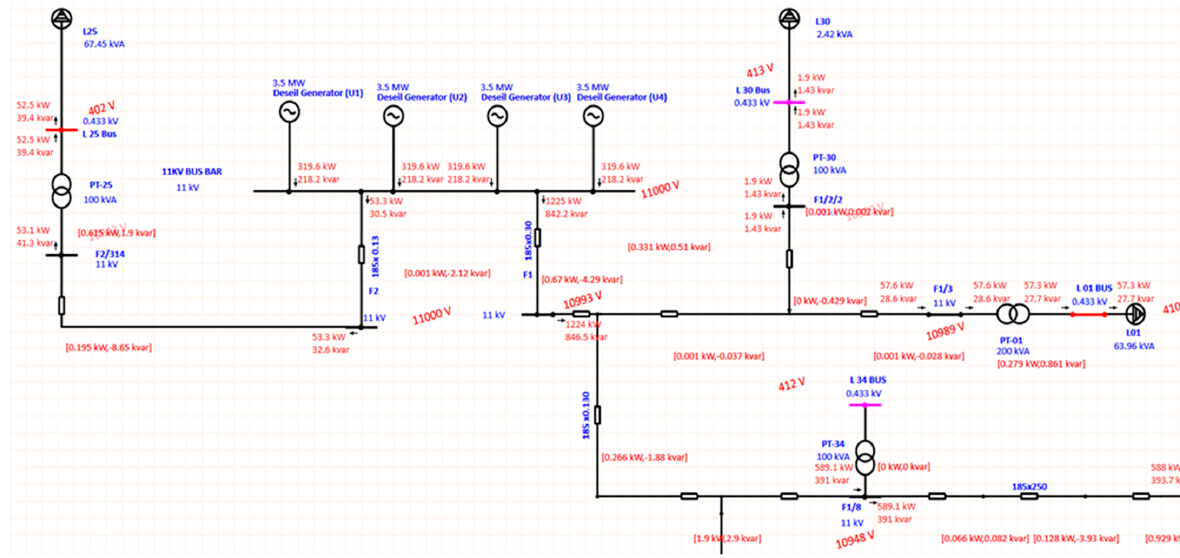
Figure 13. ETAP software model of the Al-Dhafrat distribution network (partial).